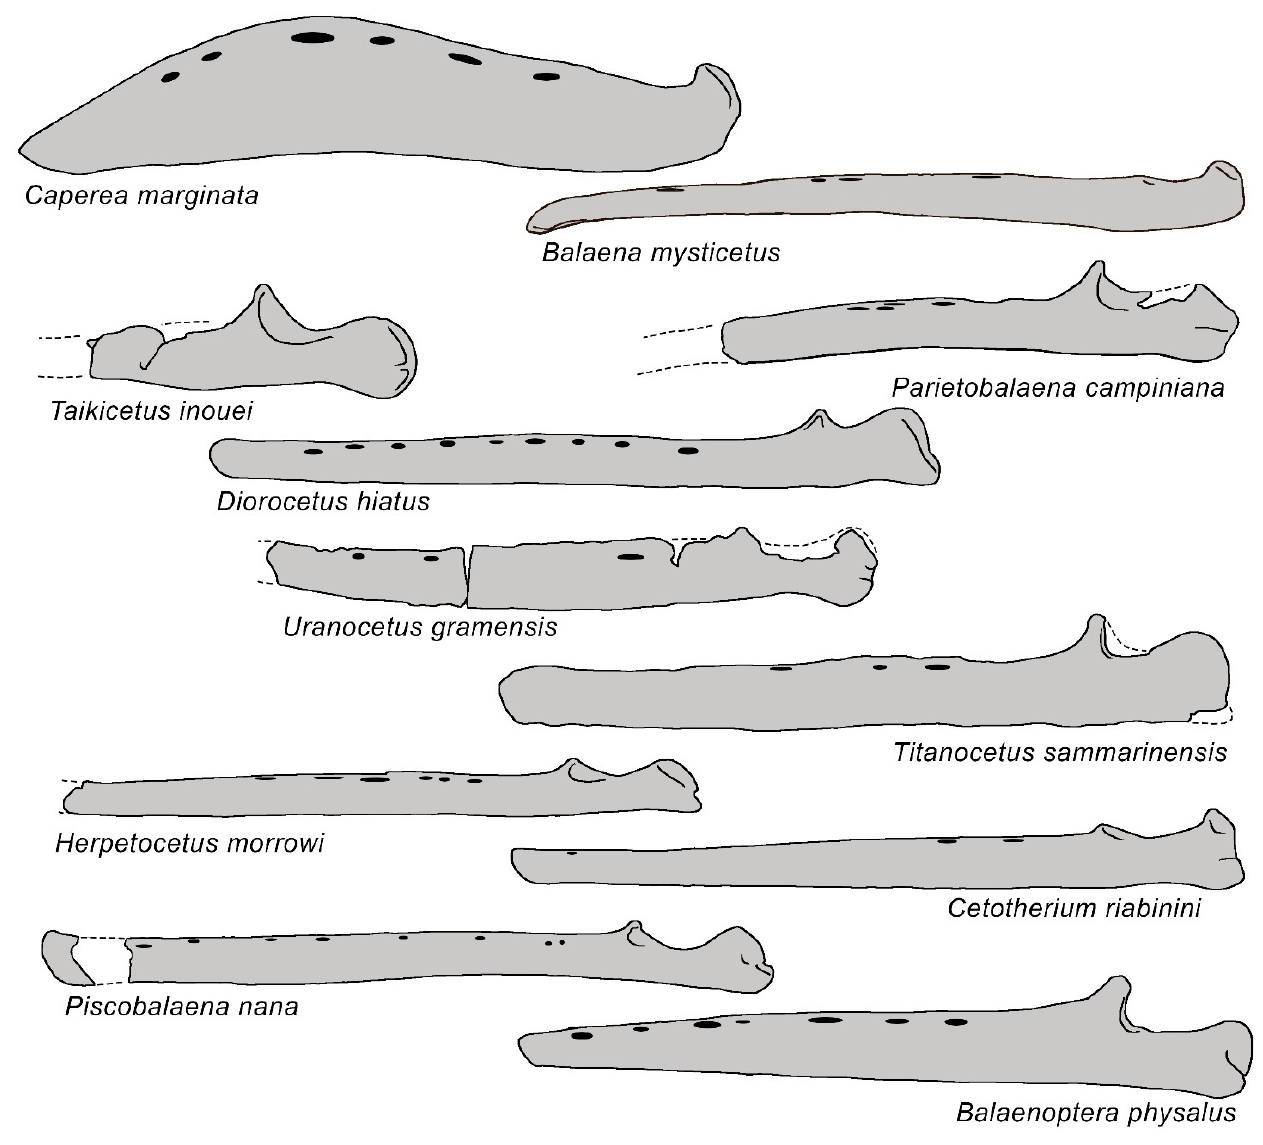
Figure 17. Schematic representations of the dentary in Balaenomorpha in lateral view. Not to scale. Dentaries are represented as if they shared the same anteroposterior length.